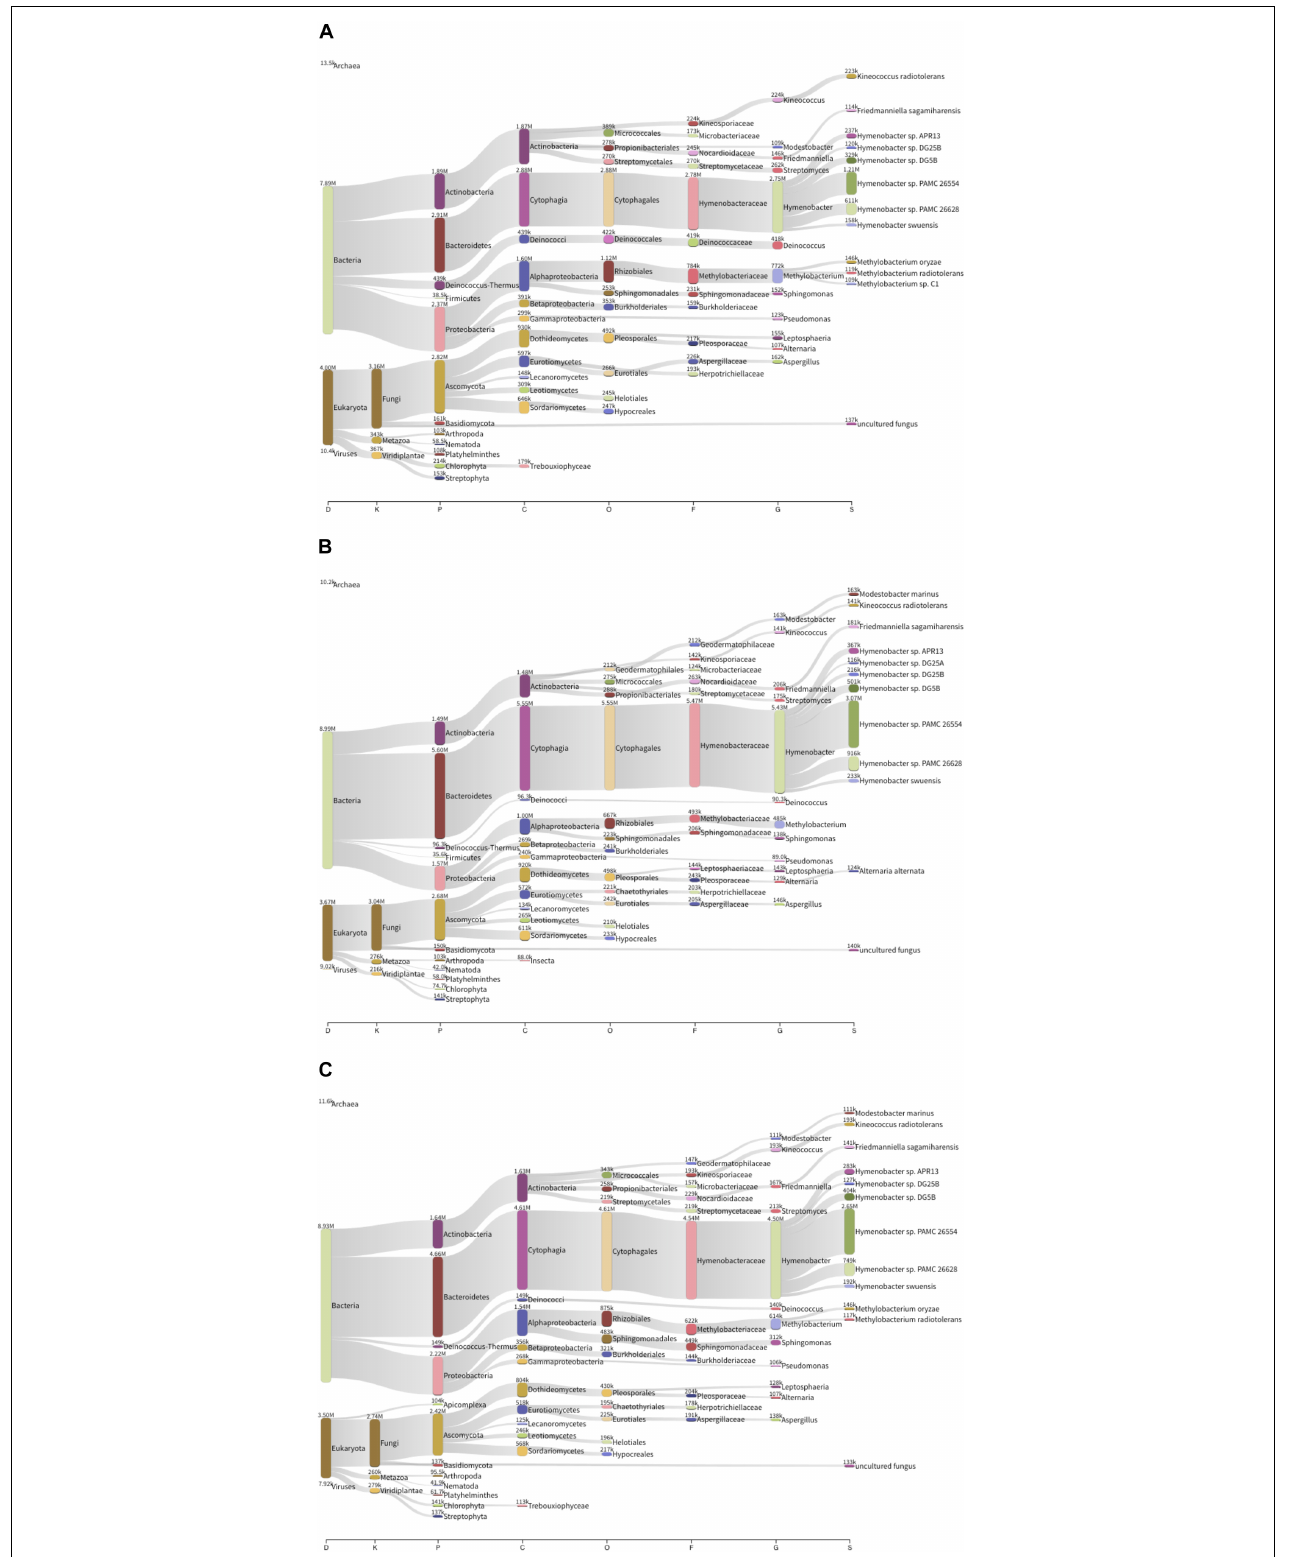
FIGURE 3 | Taxonomic composition of three solar panel microbial communities from Berkeley, CA, United States. The thickness of the lines is representative of the relative abundance of the taxa. (A) Left solar panel. (B) Center solar panel. (C) Right solar panel.